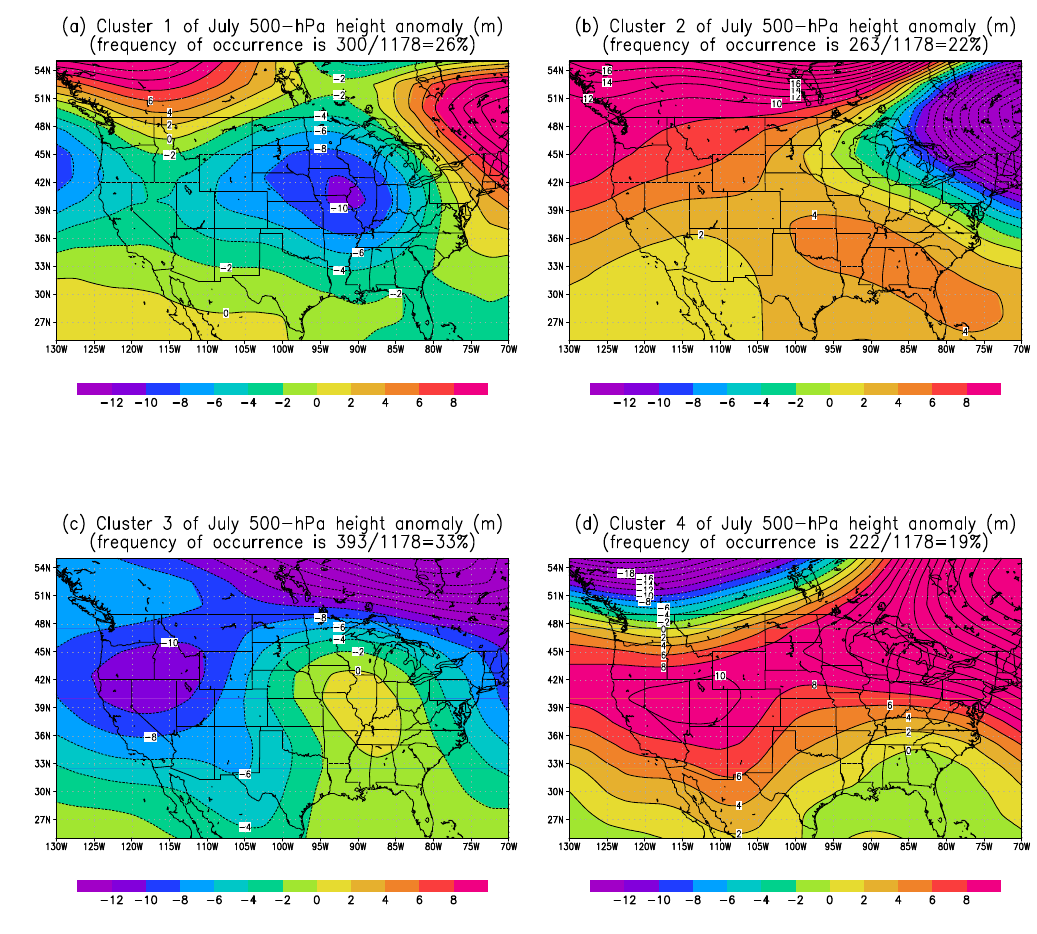
Figure 11. Same as Figure 6, except for the 38-yr July